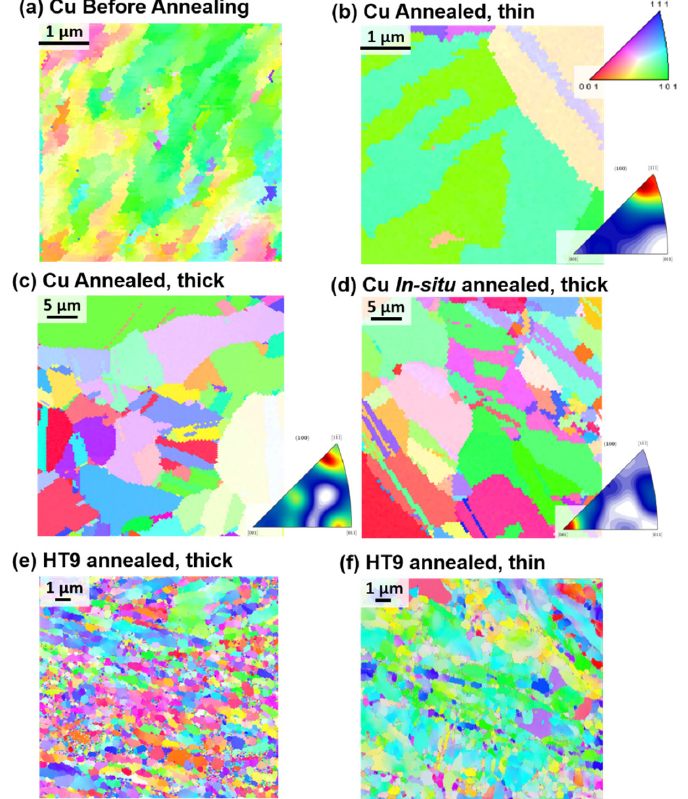
Figure 2. Inverse pole figure EBSD maps for ( a – c ) LSM Cu before and after annealing in thick and thin regions. ( d ) LSM bulk Cu material annealed. ( e , f ) HT-9 annealed in thick and thin